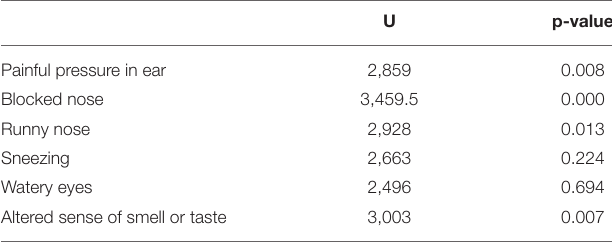
TABLE 2 | Test of between-group differences in symptom frequency at first assessment.